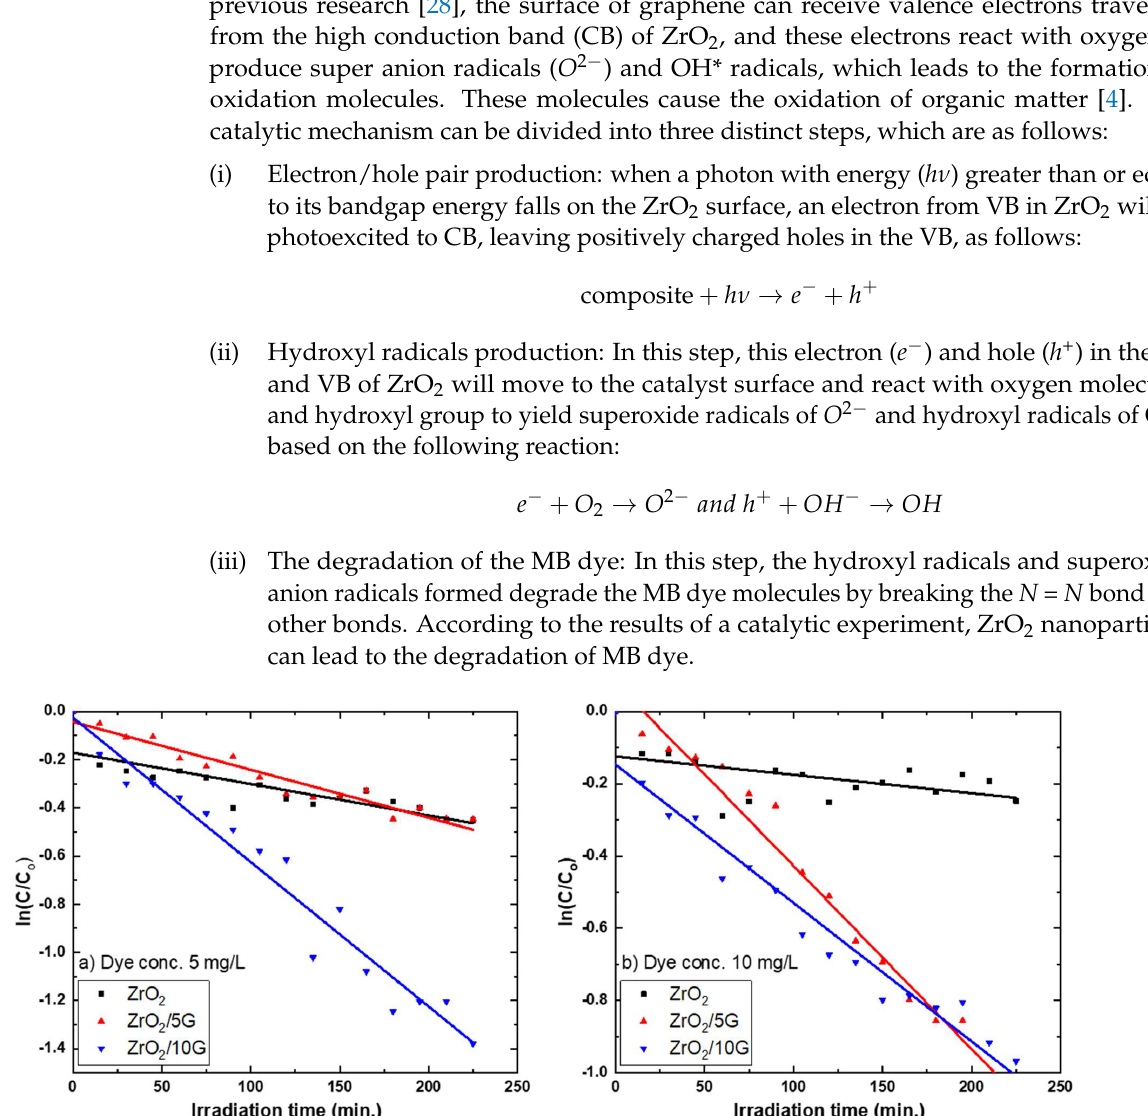
Figure 7. Semi-logarithmic graph of methylene blue (MB) concentration vs. irradiation time in the presence of ZrO 2 , ZrO 2 /G5, and ZrO 2 /G10 for both concentrations of MB of: ( a ) 5 and ( b ) 10 mg/L.